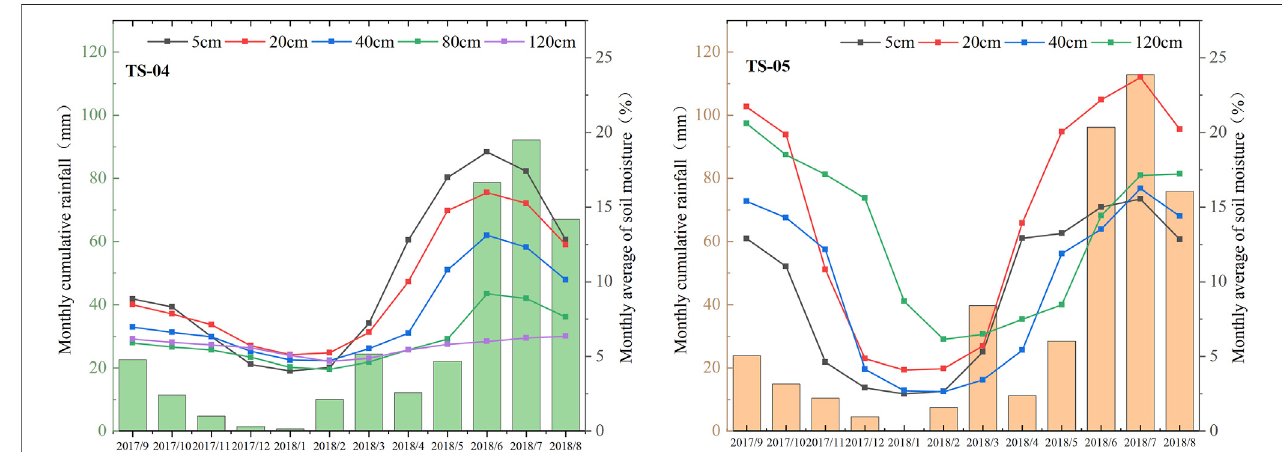
FIGURE 9 | Monthly accumulated precipitation and monthly average unfrozen water content of soil at TS-04 site and TS-05 site.